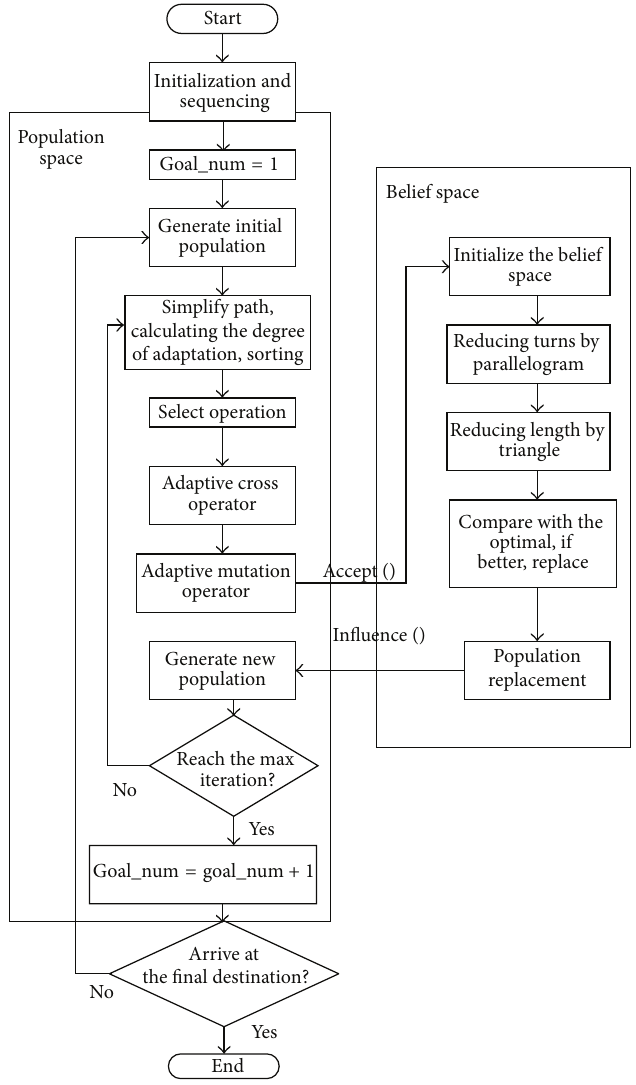
Figure 8: Flow chart of improved genetic